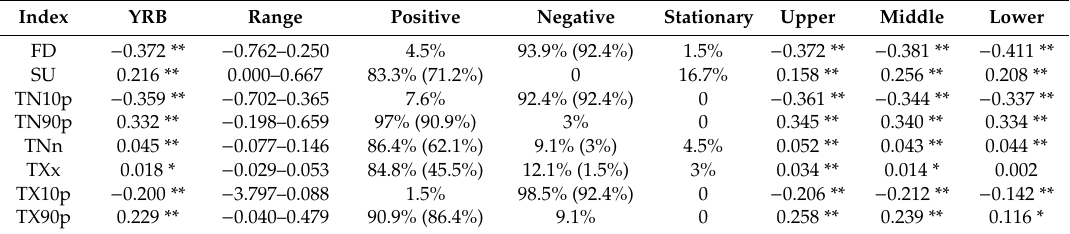
Figure 3. The spatial change of temperature extreme indices in the Yellow River basin (YRB) during 1960–2017. Table 3. Percentage of stations with positive (significant at the 0.01 level), negative (significant at the 0.01 level), and stationary trends for the trend test in annual extreme temperature indices during 1960–2017.